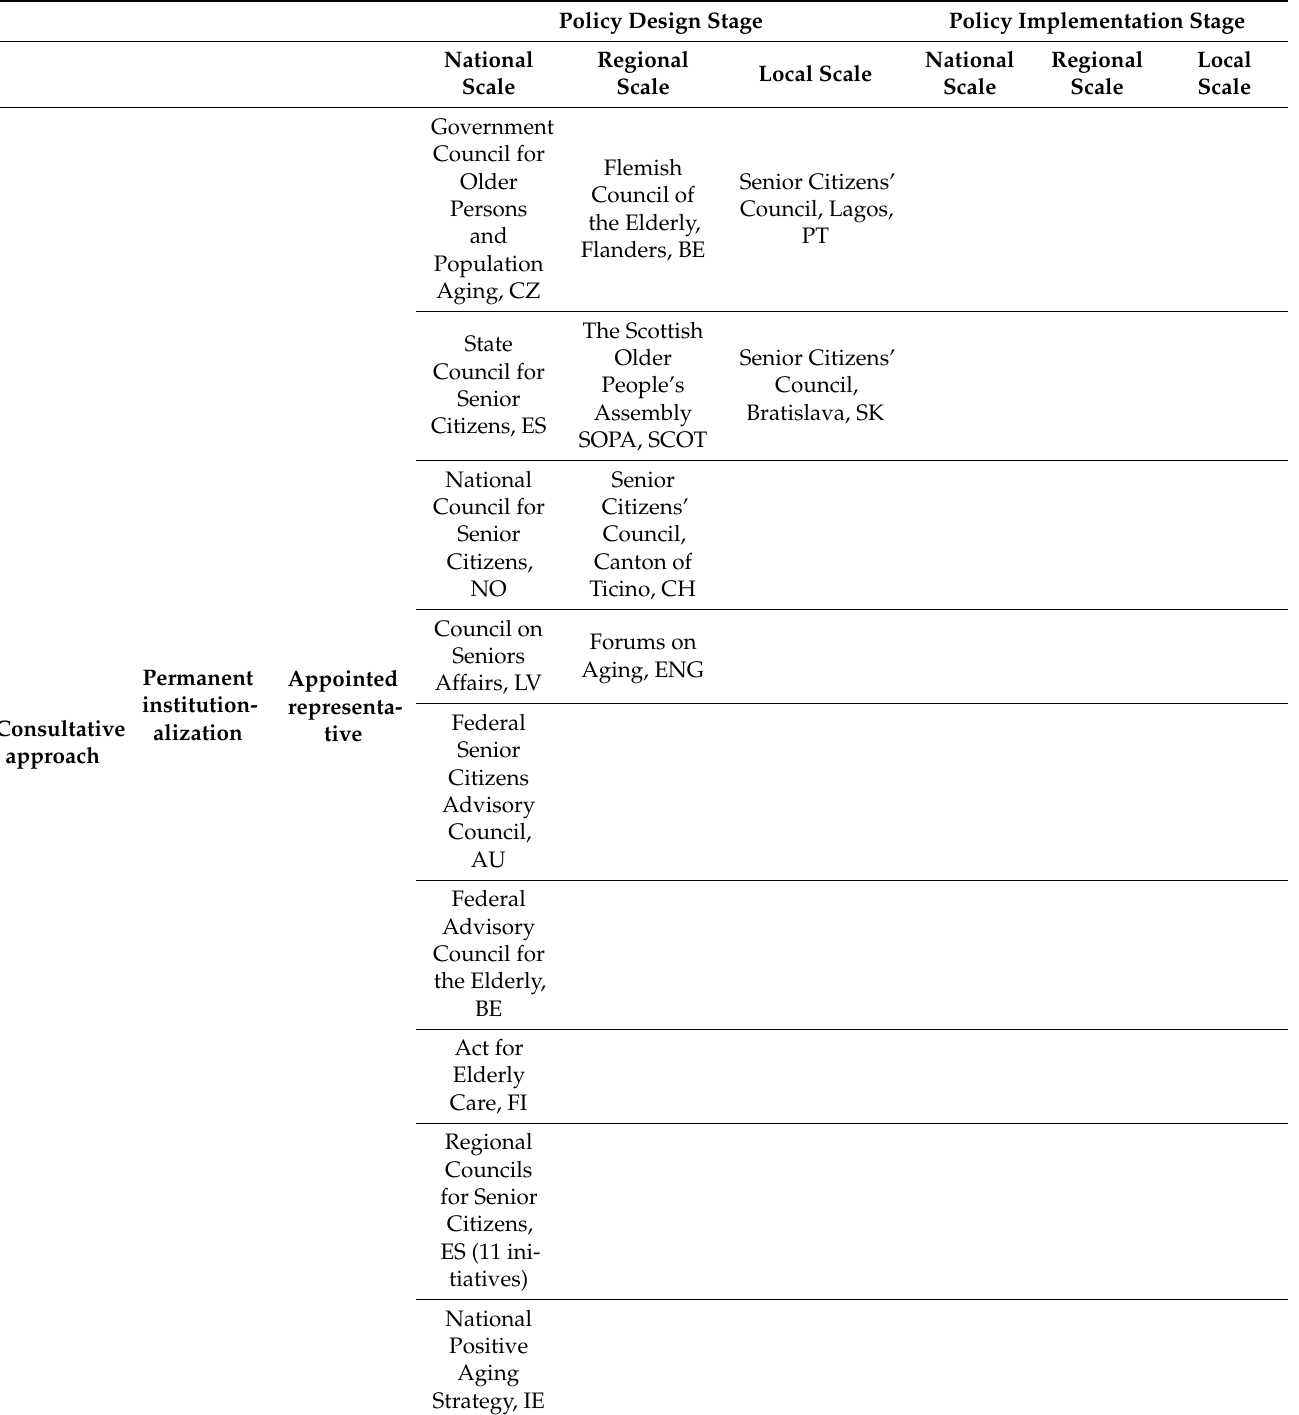
Table 5 lists the 37 initiatives according to the above coordinates. Web links to these initiatives, as retrieved at the time of the study, can be found in Appendix A. Table 5. Senior citizens’ participatory initiatives in